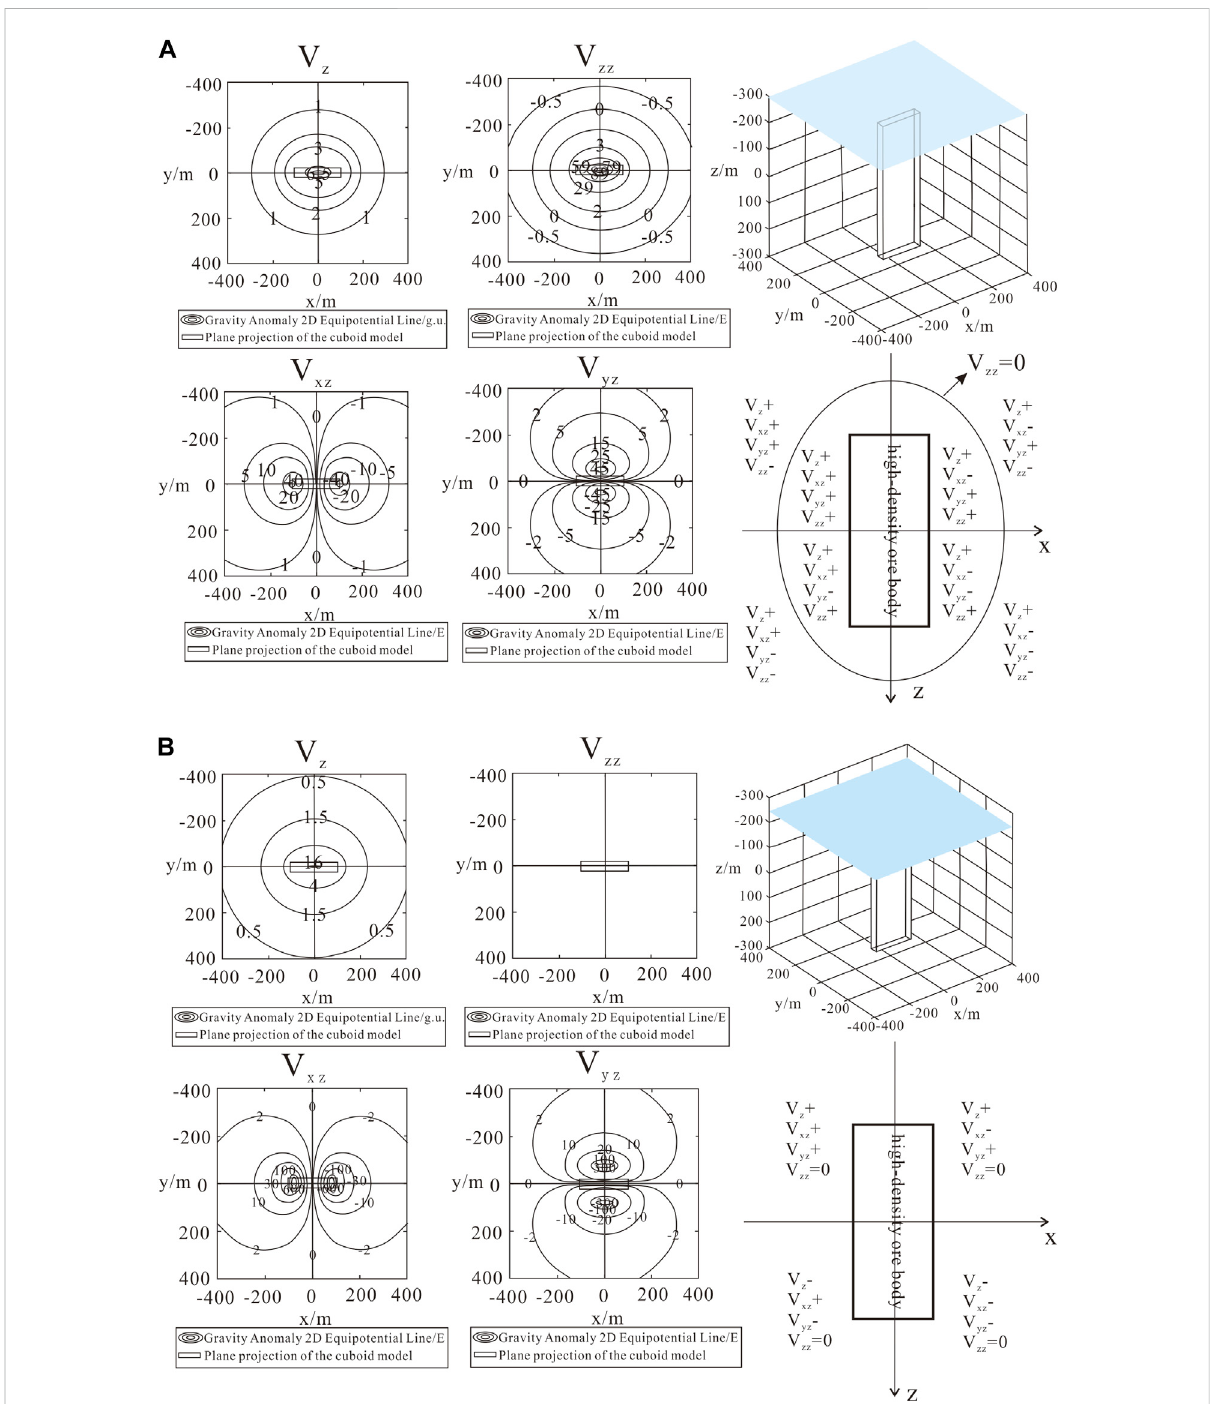
FIGURE 4 (Continued). (A) Positive and negative combination patterns of the gravity anomaly and gravity gradient anomaly on the upper plane ( z = − 300 m) of the vertical cuboid. (B) Positive and negative combination patterns of the gravity anomaly and gravity gradient anomaly on the top plane ( z = − 250 m) of the vertical cuboid. (C) Positive and negative combination patternsof the gravity anomaly and gravity gradient anomaly on the upper middle plane ( z = − 125 m) of the vertical cuboid. (D) Positive and negative combination patterns of the gravity anomaly and gravity gradient anomaly on the middle plane ( z = 0 m) of the vertical cuboid. (E) Positive and negative combination patterns of the gravity anomaly and gravity gradient anomaly on the lower middle plane ( z = 125 m) of the vertical cuboid. (F) Positive and negative combination patterns of the gravity anomaly and gravity gradient anomaly on the bottom plane ( z = 250 m) of the vertical cuboid. (G) Positive and negative combination patterns of the gravity anomaly and gravity gradient anomaly on the lower plane ( z = 300 m) of the vertical